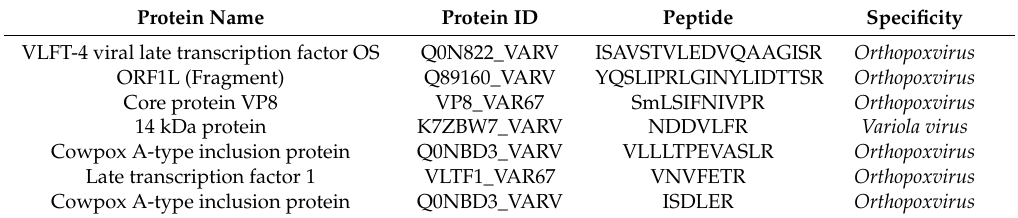
Table 1. List of orthopoxvirus- and variola virus-specific proteins, peptides and their amino acid sequences. Protein